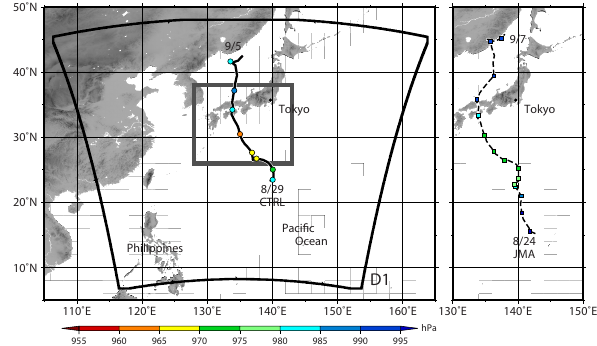
Figure 1. Computational domain 1 used in the present study except for the CTRL experiment and the tracks of Typhoon Talas (2011) from the best track data provided by JMA (black dashed line with squares) and CTRL (purple solid line with circles). Colored sym- bols represent the sea-level pressure of the typhoon at 00:00UTC every